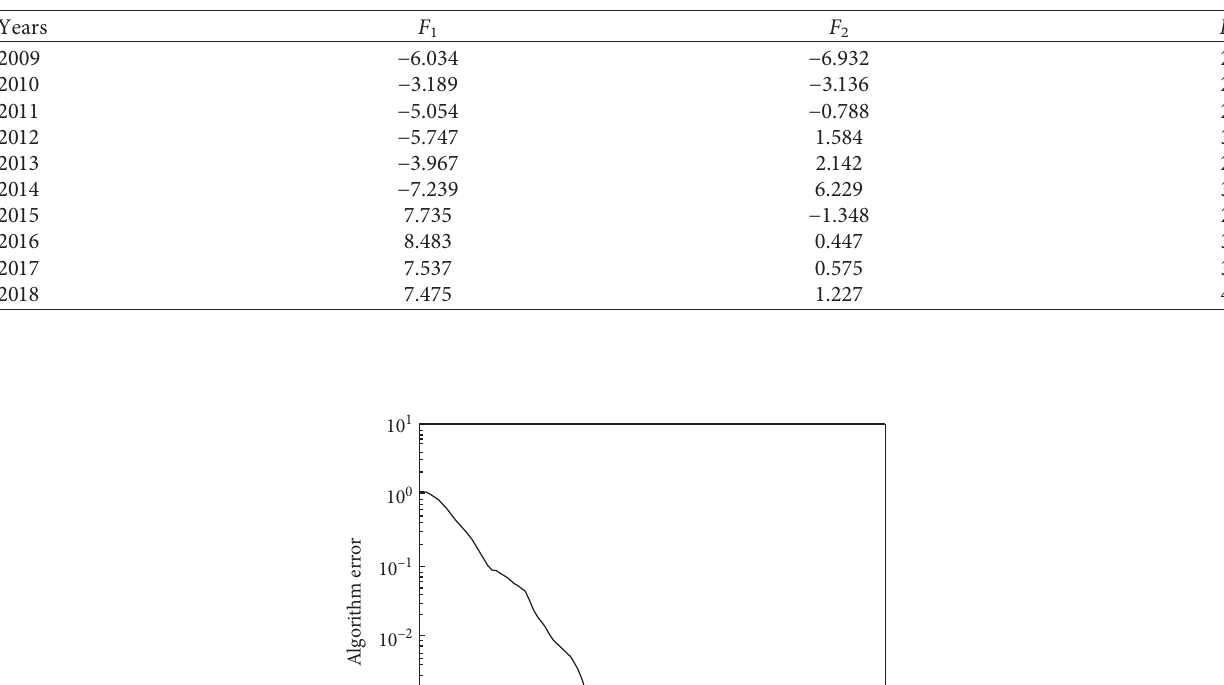
Table 7: Calculated data of principal